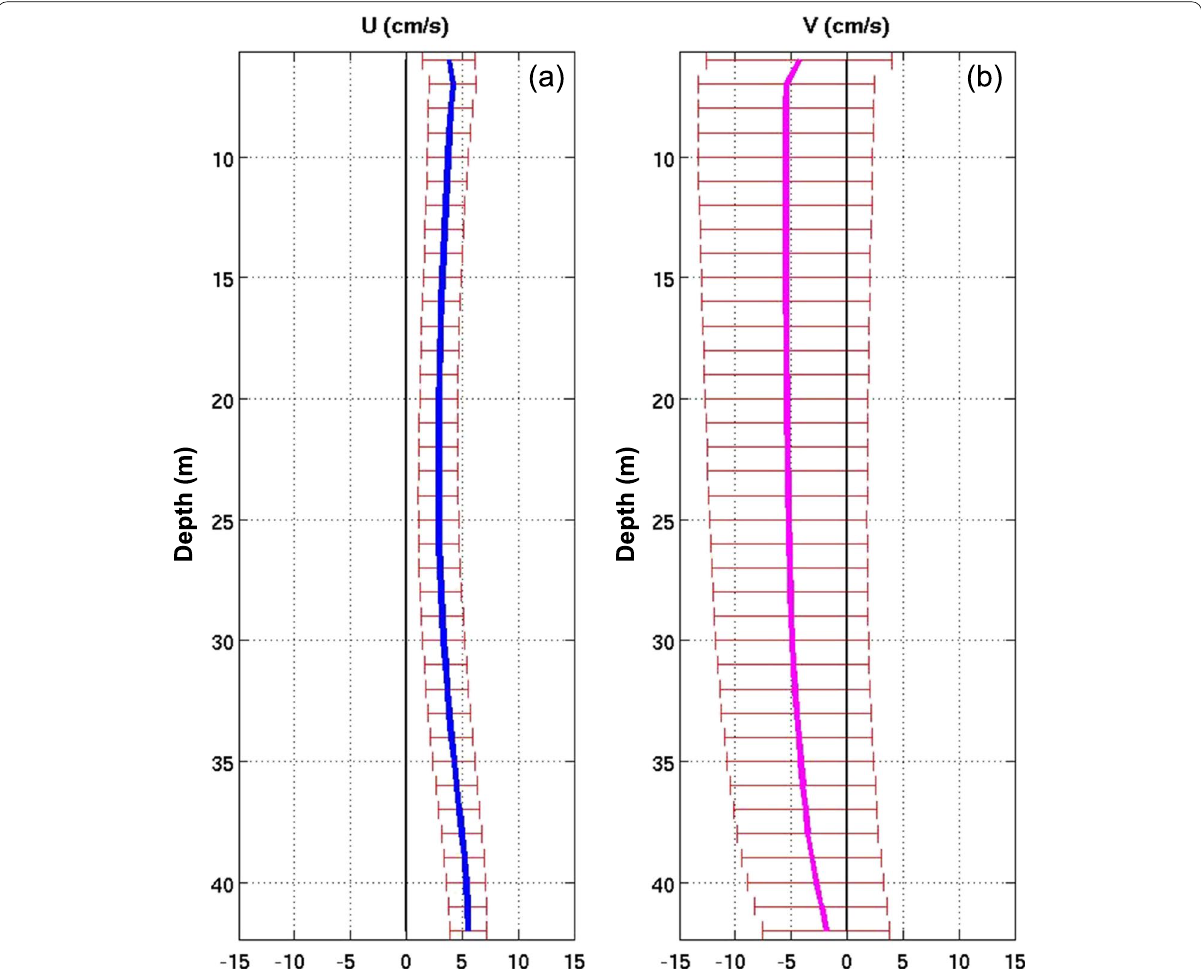
Fig. 10 Mean vertical structure and variability of subtidal currents. a Cross‑channel component, b Along‑channel component. Horizontal lines in figures ( a ) and ( b ) represent one standard